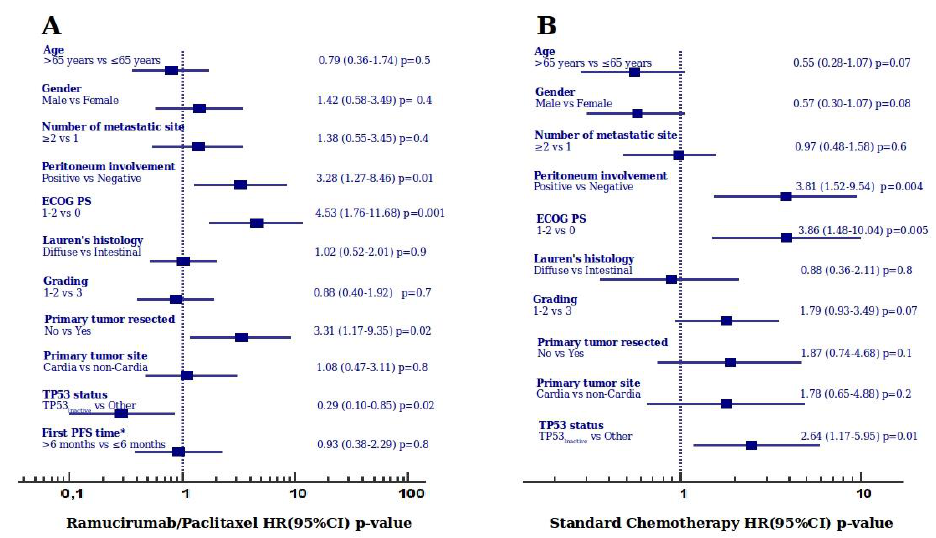
Figure 2. Results of the multivariate model analysis for overall survival in the Ramucirumab/Paclitaxel ( A ) and Standard Chemotherapy ( B ) treatment groups. Abbreviations: HR, Hazard Ratio; CI, confidence interval; ECOG PS, Eastern Cooperative Group Performance Status; PFS, progression-free survival. First PFS time* is a variable for second-line Ramucirumab/Paclitaxel therapy only.